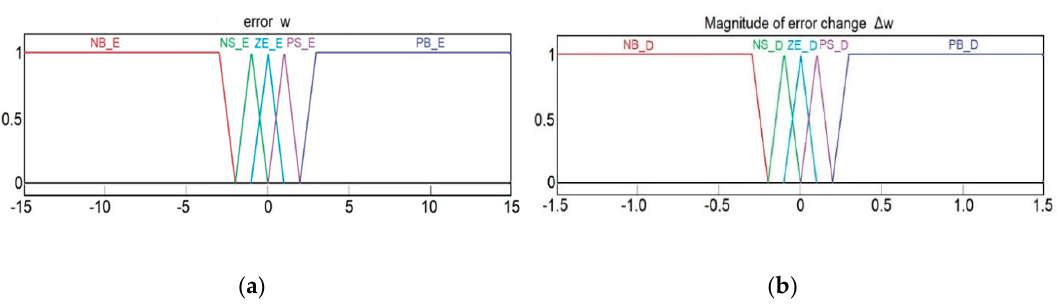
Figure 13. Membership functions for: ( a ) Error of generator shift speed, ( b ) magnitude of error changes.